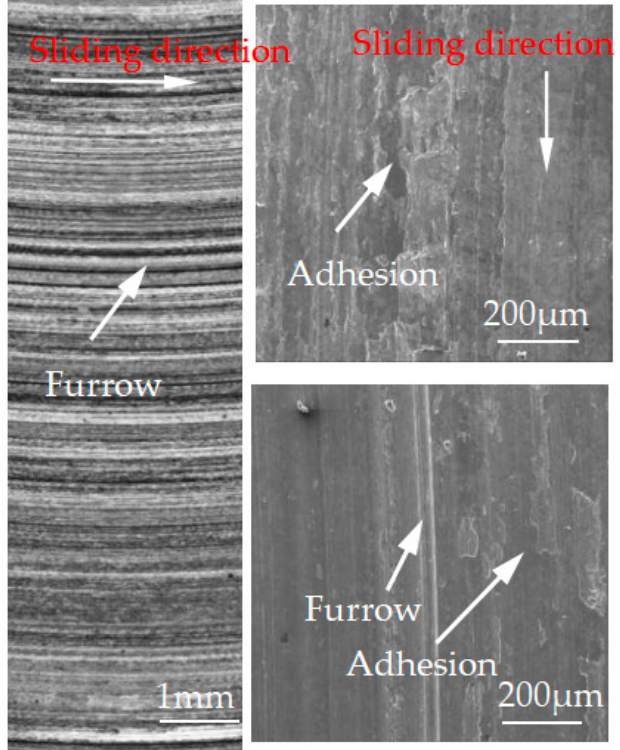
Figure 12. Surface morphology of the disc material after intermittent braking at an ambient tempera- ture of 20 ◦